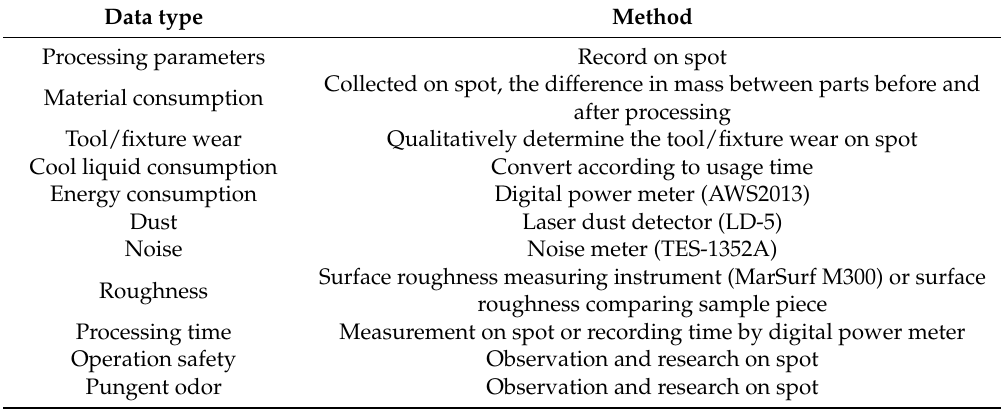
Table 10. Data collection